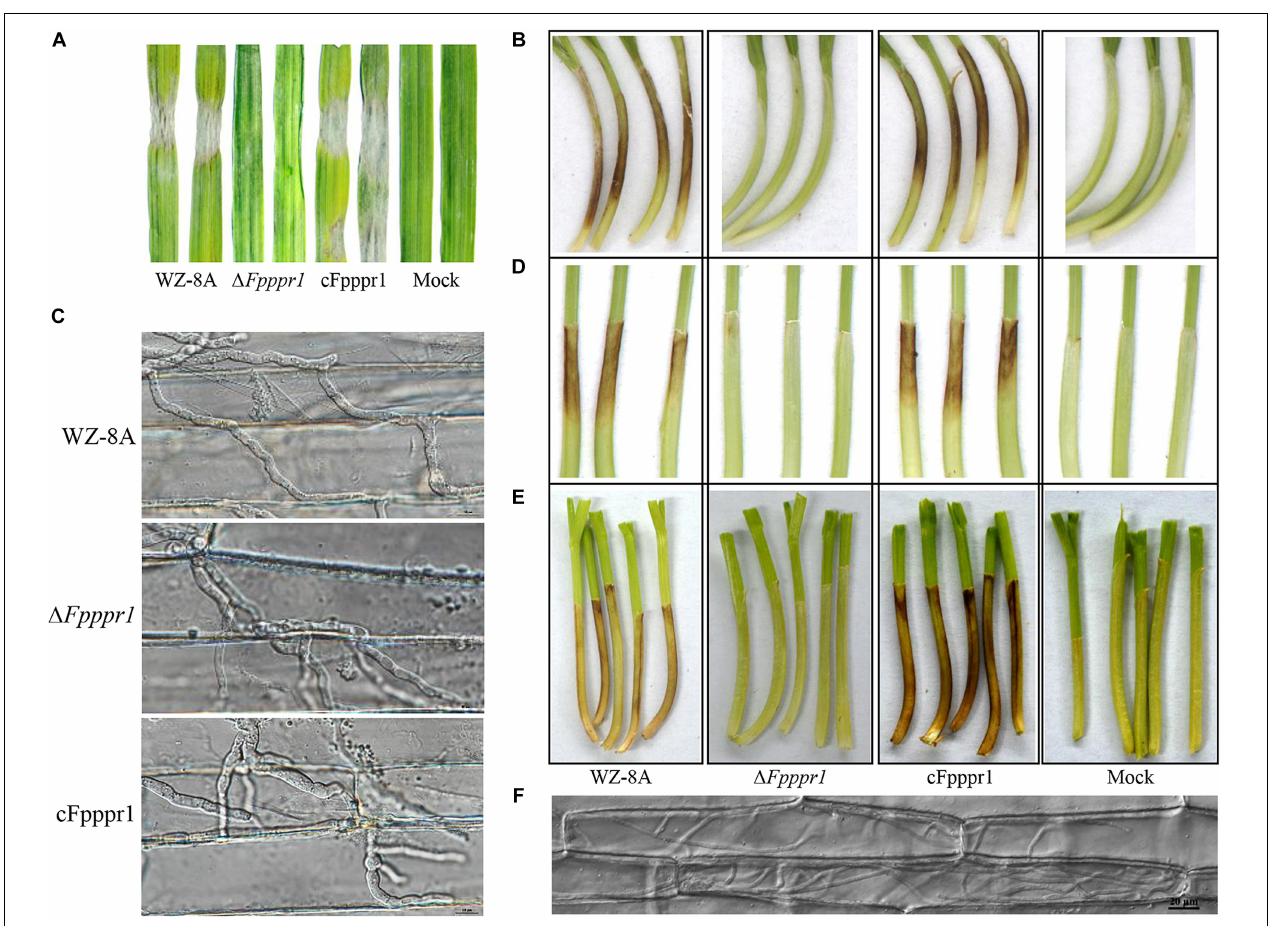
FIGURE 6 | Pathogenicity test assay using WZ-8A, (cid:49) Fpppr1 , and cFpppr1. (A) Barley leaves were inoculated with fungal mycelia plugs (5 mm diameter) or PDA plugs without mycelia as a mock. (B) Wheat coleoptiles with inoculation of fungal or PDA plugs for 3 d. The plugs were removed after 24 h. (C) Histopathological images of infectious hyphae in the abaxial epidermis of wheat coleoptiles 3 dpi. Scale bars indicate 10 µ m. (D) Wheat coleoptiles were inoculated with spore suspension and sterile water as mock and photographed at 8 dpi and (E) at 16 dpi. (F) Histopathological images of infectious hyphae in the abaxial epidermis of wheat coleoptiles 14 dpi. The images were taken under Nikon Eclipse Ti-S microscopy in DIC (differential interference contrast) model. Scale bars indicate 20 µ m.